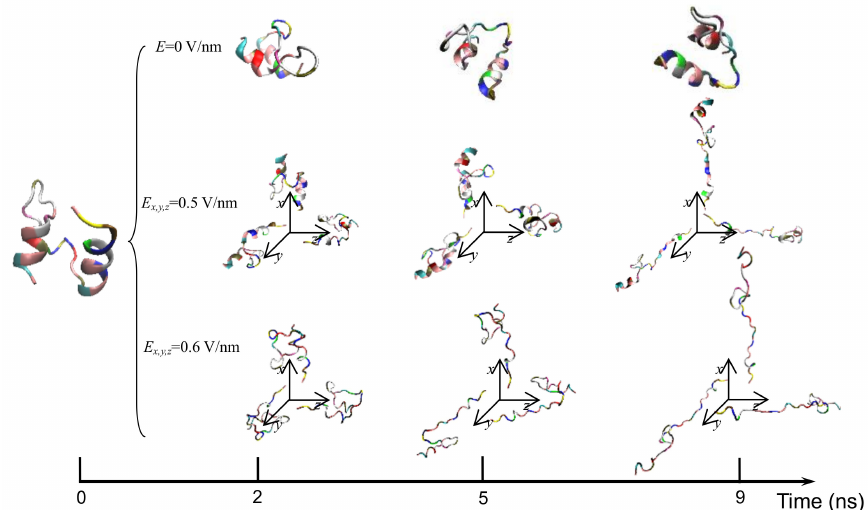
Figure 4. (Colored) Typical conformation of the protein 1BBL exposed in the electric fields with the strength Ex,y,z = 0 V/nm, 0.5 V/nm, and 0.6 V/nm during the simulation process,